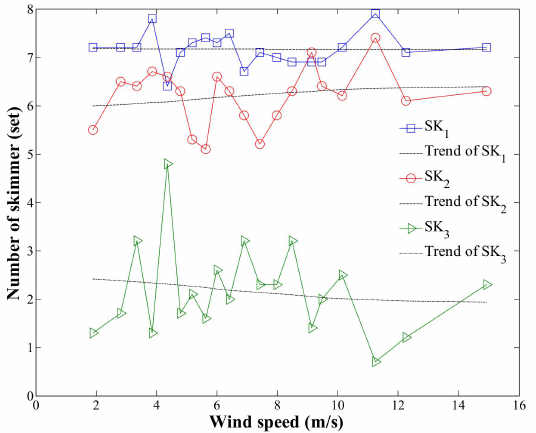
Figure 13. Changes of skimmer combination regarding the uncertainty of slick area.